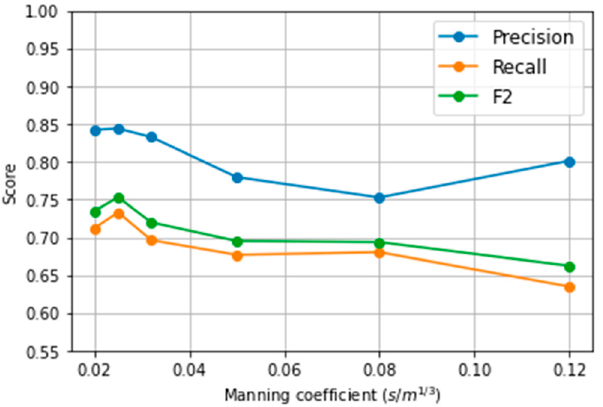
Figure 7. Accuracy measures as a function of the Manning coefficient.